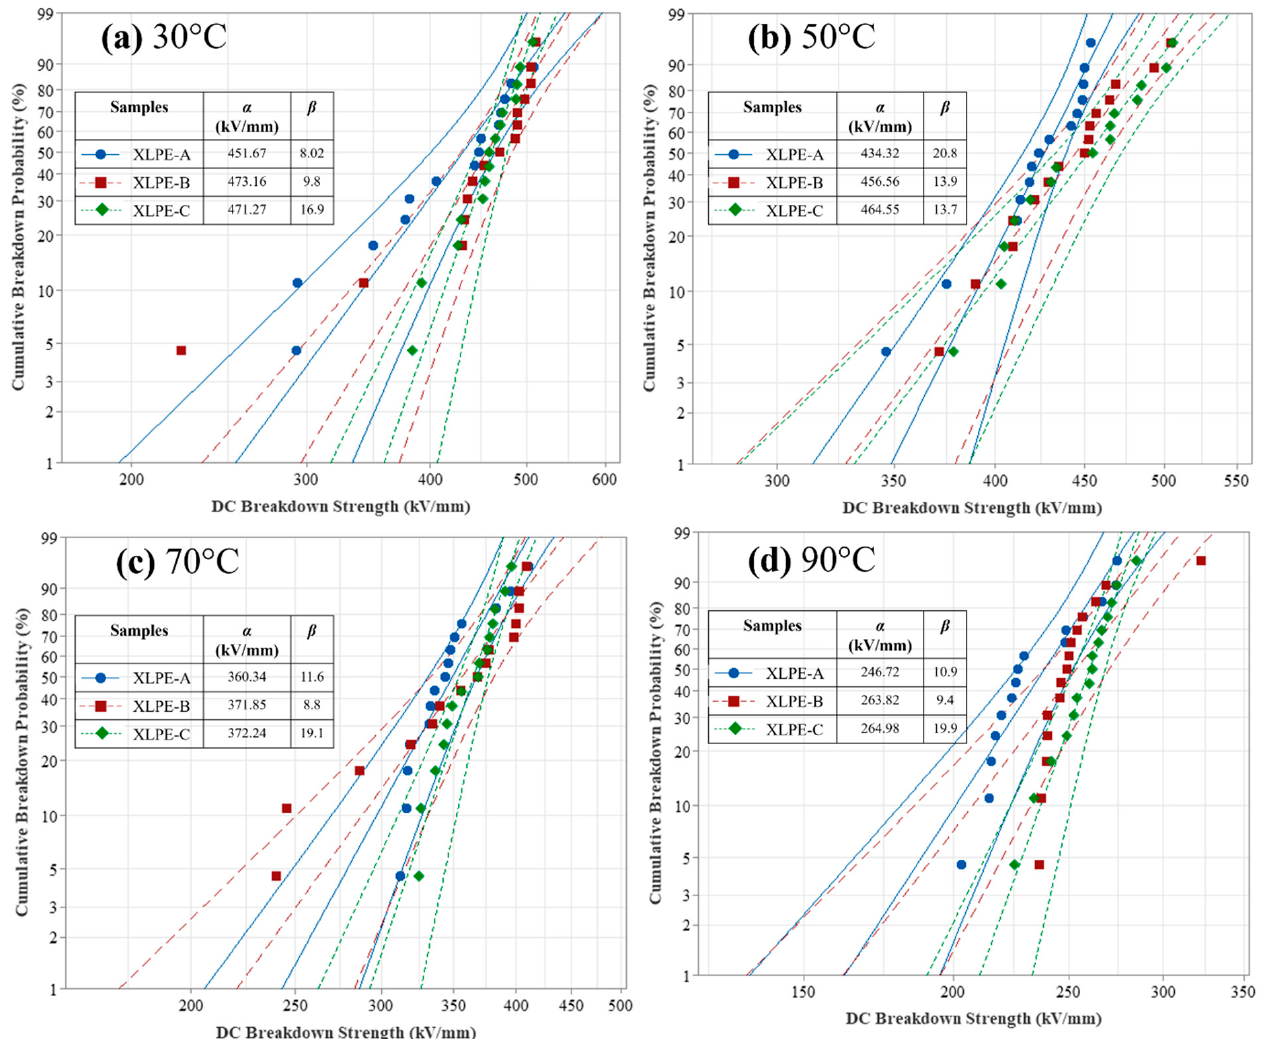
Figure 10. Weibull distribution plot of DC breakdown strength at 30–90 °C for XLPE prepared with DCP content of 1.4% (XLPE-A), 1.7% (XLPE-B) and 2% (XLPE-C). The centered fitted line in the Weibull distribution plot is representing the breakdown probability. The left and the right fitted lines in Weibull distribution plot are representing the 95% lower confidence limit and 95% higher confidence limit of breakdown probability, respectively. ( a ) At no load temperature condition i.e., 30 °C. ( b ) At operating temperature condition i.e., 50 °C. ( c ) At operating temperature condition i.e.,